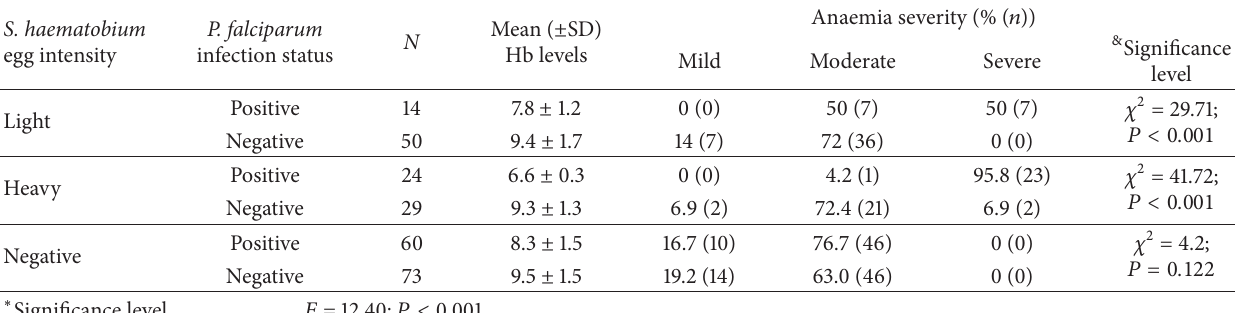
Table 5: Association between S. haematobium intensity, P. falciparum infection, and mean ( ± SD) haemoglobin levels and anaemia severity. S. haematobium egg